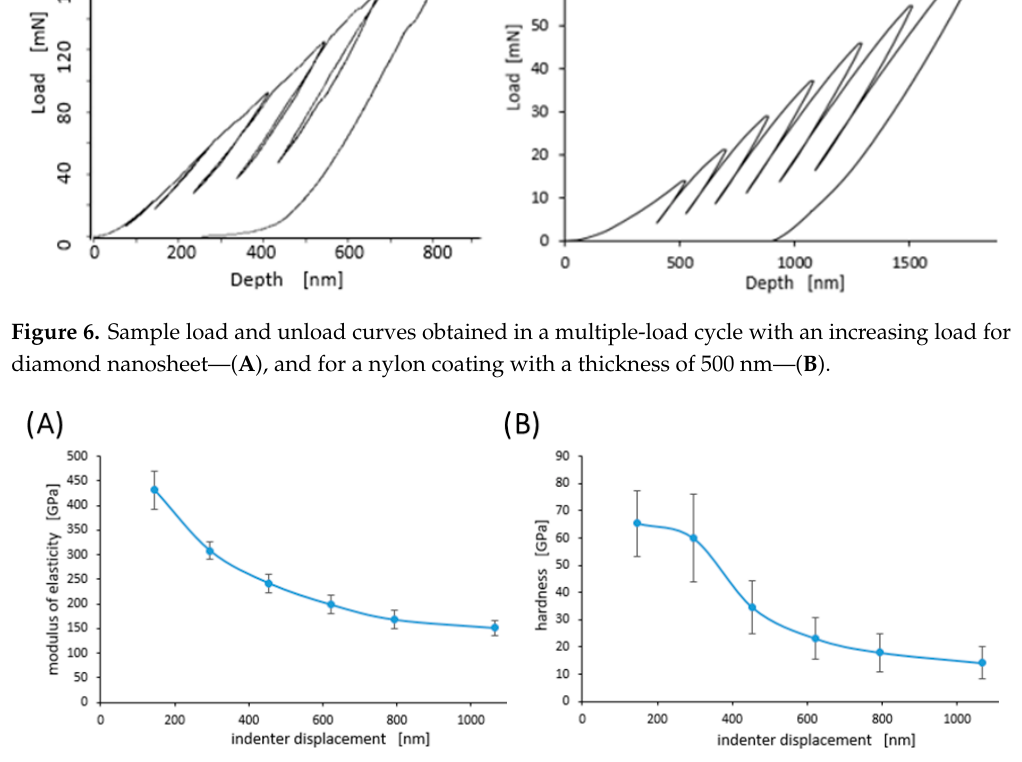
Figure 8. Hardness—( A ), and modulus of elasticity—( B ) for a nylon coating with a thickness of 2000 nm. Error bars represent ± standard deviation. Figure 9. Hardness—( A ), and modulus of elasticity—( B ) for a nylon coating with a thickness of 500 nm and for a transition zone. Error bars represent ± standard deviation.